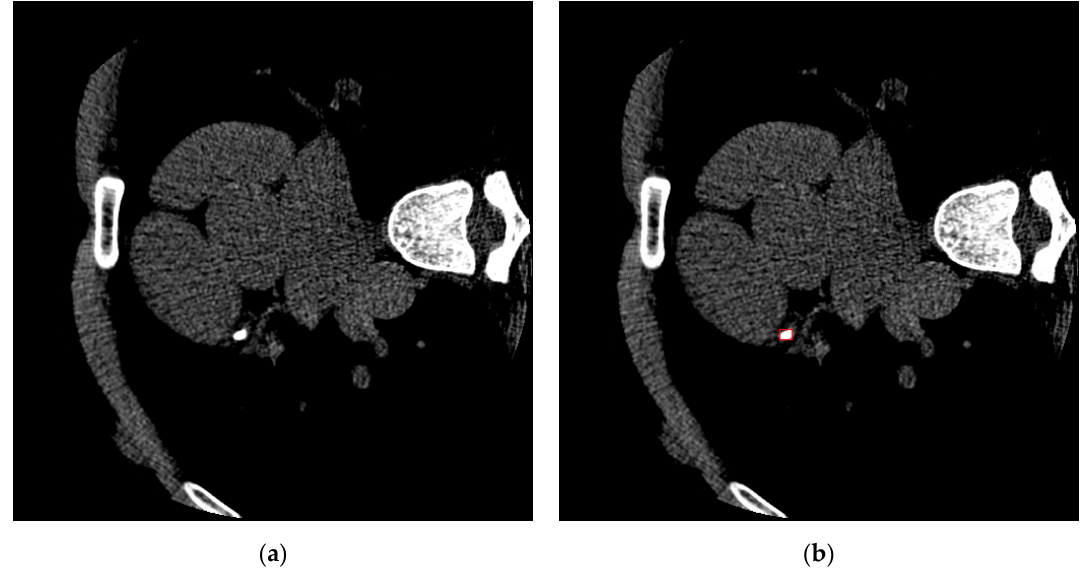
Figure 2. An example of an image and corresponding ground truth. ( a ) An image of one patient in orCaScore. ( b ) The corresponding ground truth, the red bounding box points out the calcified plaques in this image.